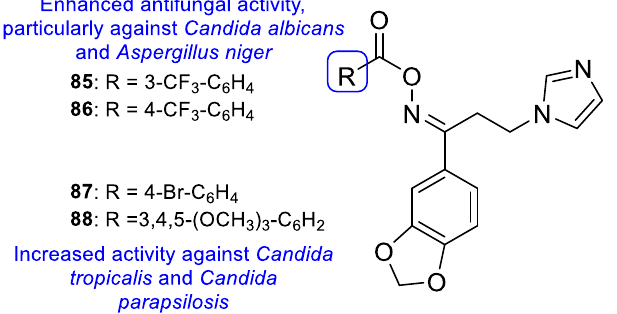
Figure 43 . Chemical structures of compound 85 – 88 , and SAR [123]. Figure 43. Chemical structures of compound 85 – 88 , and SAR